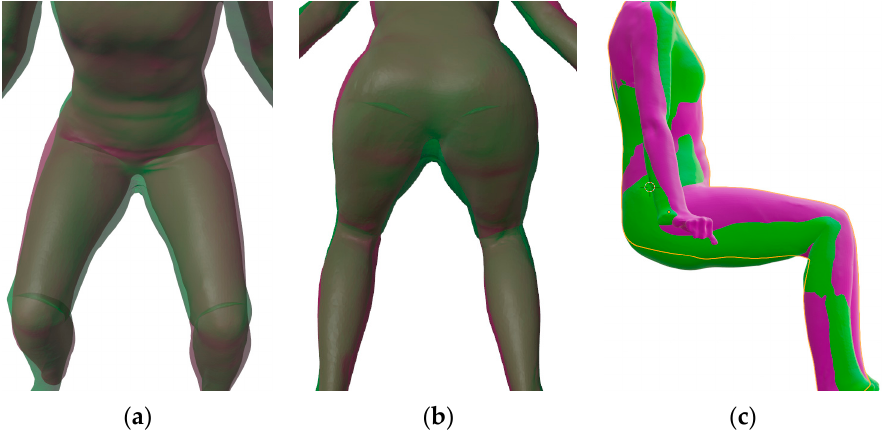
Figure 7. Overlapping meshes of a sitting 3D body model (3DBMSIT) (purple) and kinematic sitting 3D body model (K3DBMSIT) (green): ( a ) the upper front view, ( b ) the lower bottom view, ( c ) side view.